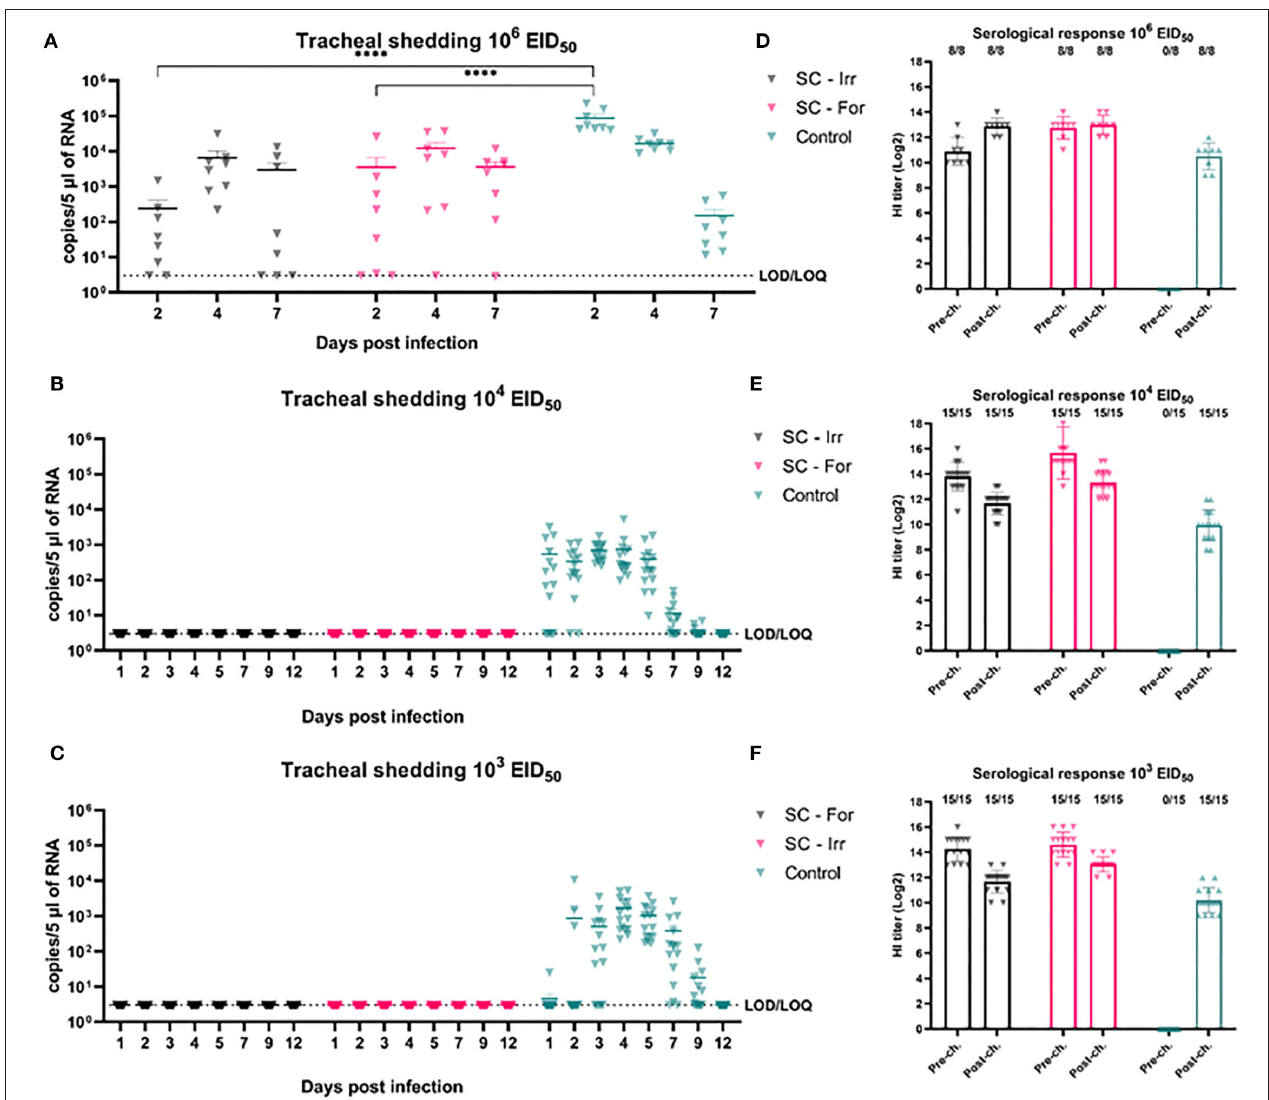
FIGURE 2 | Effects of subcutaneous (SC) vaccination upon infection at different H9N2 challenge doses. (A–C) qRRT-PCR results of tracheal swabs collected from all the challenged birds. (D–F) Serological test results of blood samplings performed before and after challenge. The numbers above bars indicate a number of NP-ELISA positive birds out of tested